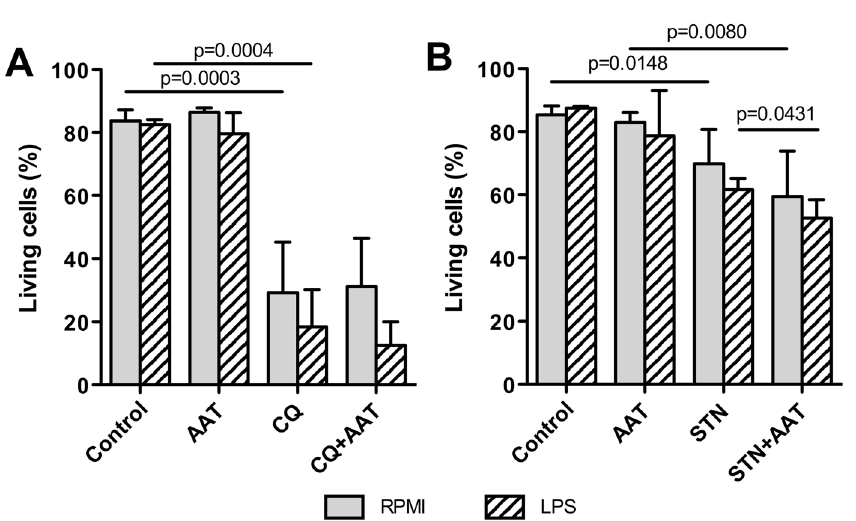
Figure 5. Exogenously added AAT does not interfere with chloroquine (CQ) or streptonigrin (STN)-induced apoptosis in H1975 cells independent on the presence of LPS. Cells were treated with 200 µ M CQ or 200 nM STN alone or together with AAT (1.5 mg/ml) and LPS (10 µ g/ml) for 18 h. Percentages of living cells were determined by flow cytometry using PE Annexin V Apoptosis assay. Each bar represents mean (SD) of three independent experiments. p < 0.05 was considered as